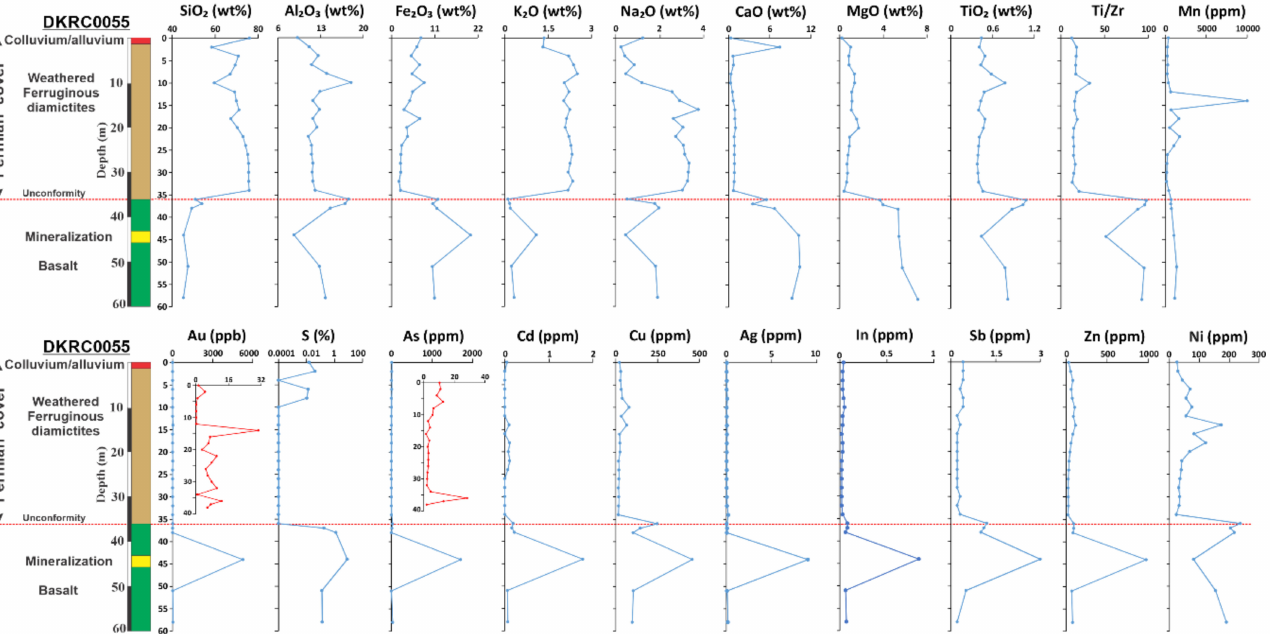
Figure 16. Vertical chemical variations in major oxides and selected trace elements in the Permian diamictites and the underlying basalt in drill hole DKRC0055. The inset profiles for Au and As show the distribution of concentrations in the diamictites and the top part of the basalt above the